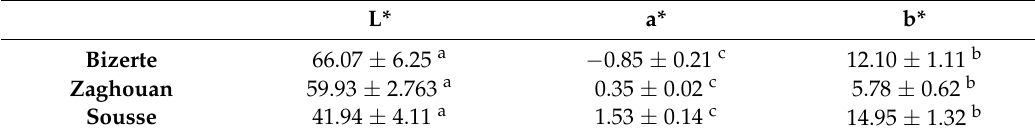
Values with different letters in the same column are significantly different p < 0.05. Values are means ± SD of three determinations.